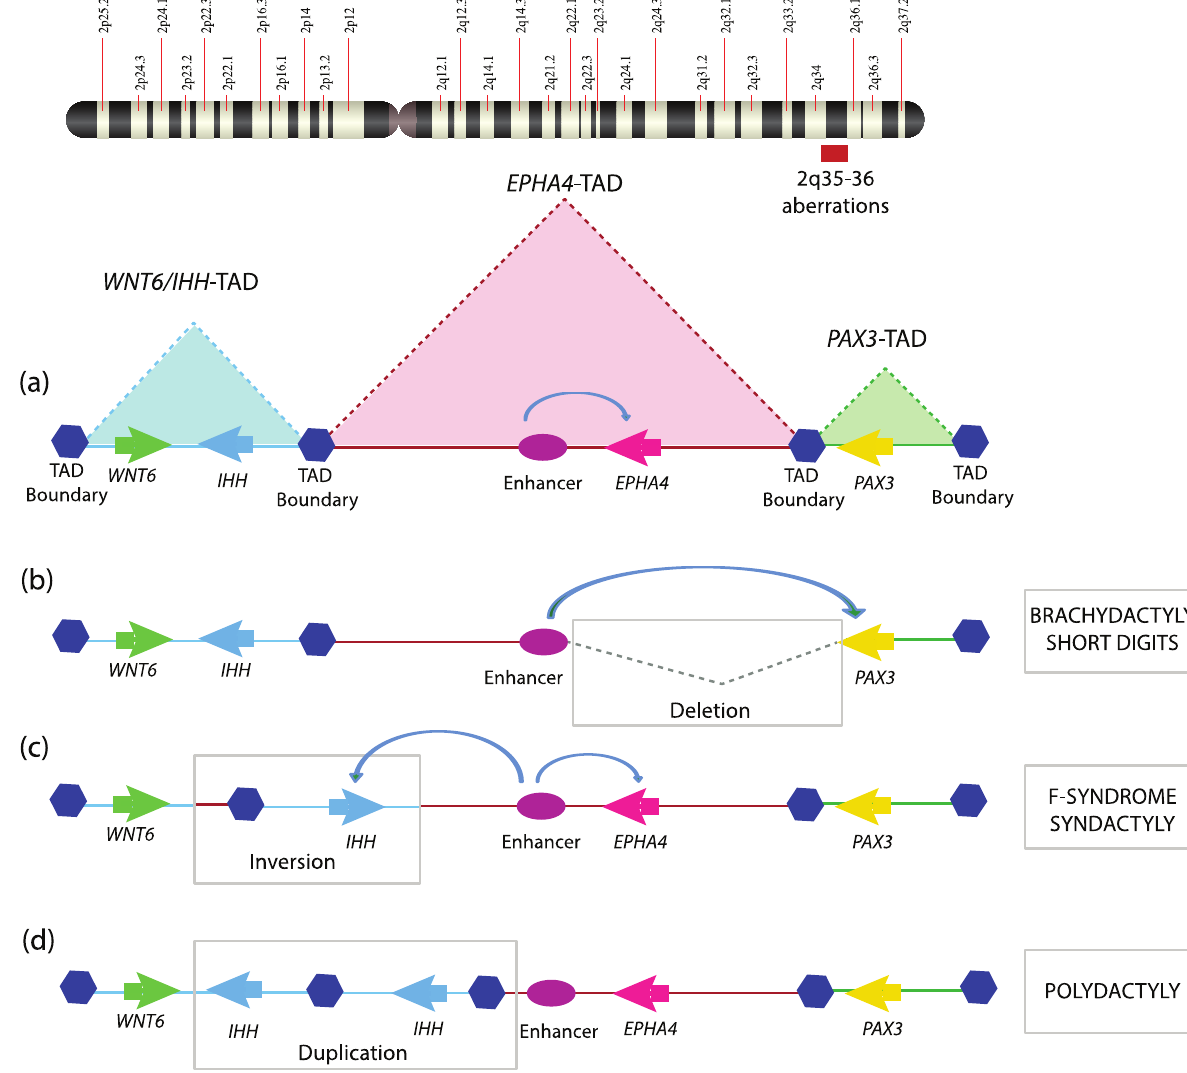
Figure 2. Topological domain disruption linked to limb malformations. Mutations encompassing the WNT6-IHH/EPHA4/PAX3 locus on human chromosome 2q arm disturb TAD structuring and are thus involved in limb phenotypes; ( a ) The WNT6-IHH/EPHA4/PAX3 locus is